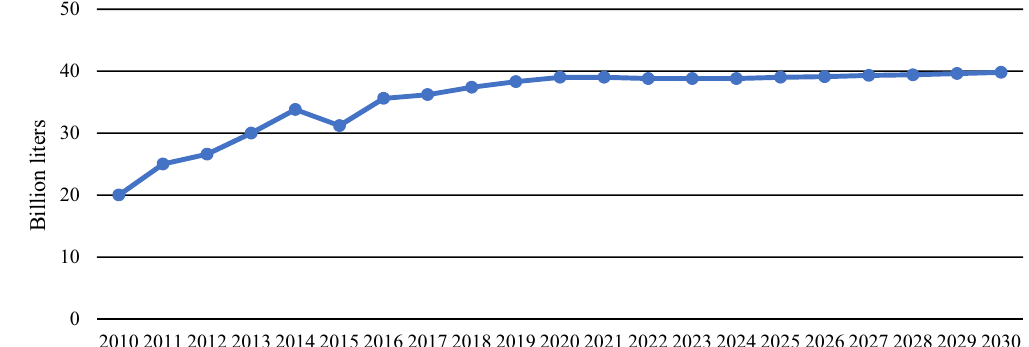
Figure 1: Estimation of global biodiesel